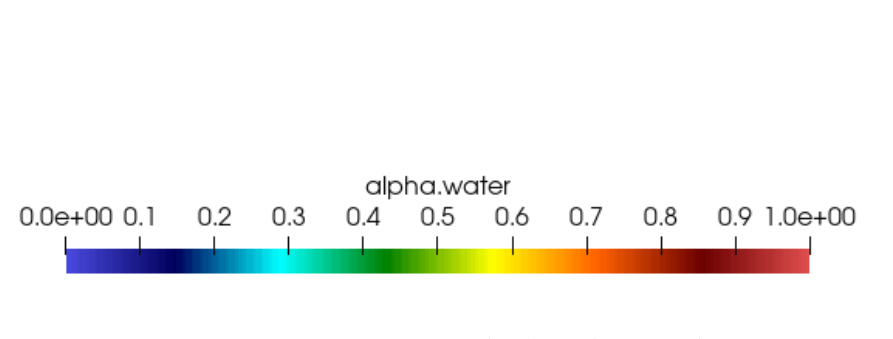
( a ) Contour of volume fraction of water Figure 4. Cont